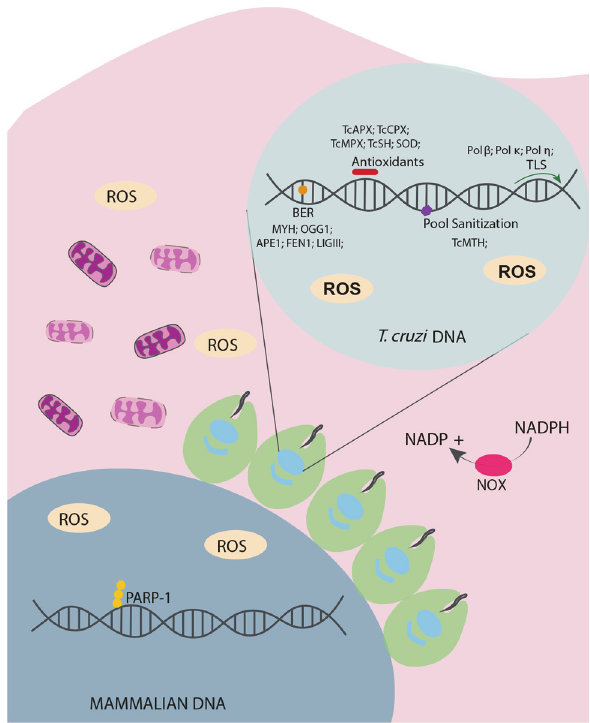
Figure1 -Oxidativestressinparasite-hostinteractionin T.cruzi. Afterin- fection, the parasite faces oxidative stress induced by the host cell. Para- sites have several defense mechanisms to prevent damage to the nuclear andkinetoplastDNA.Thefirstlineofdefenseiscomposedofseveralanti- oxidants proteins; of these, TcAPX, TcCPX, TcMPX, TcSH, and SOD proteins are the best characterized. ROS that escape from the antioxidant system can cause DNA damage when they encounter parasite DNA mole- cules (8-oxoG is the most common modification that arises from this stress). To prevent the deleterious effects, the parasite has a specific BER subsystem (GO System), that directly interacts with the modified base within the genome (TcOGG1) or any mispair with this base (TcMYH). The BER repair system has been extensively studied in the parasite and proteins from all steps of this repair pathway have been characterized. The last component of the GO system, the TcMTH protein, has also been iden- tified in T. cruzi . If any damage persists in the parasite’s nuclear or mito- chondrial genome, translesion polymerases have also been identified, demonstrating that the parasite has means to survive massive amounts of oxidative